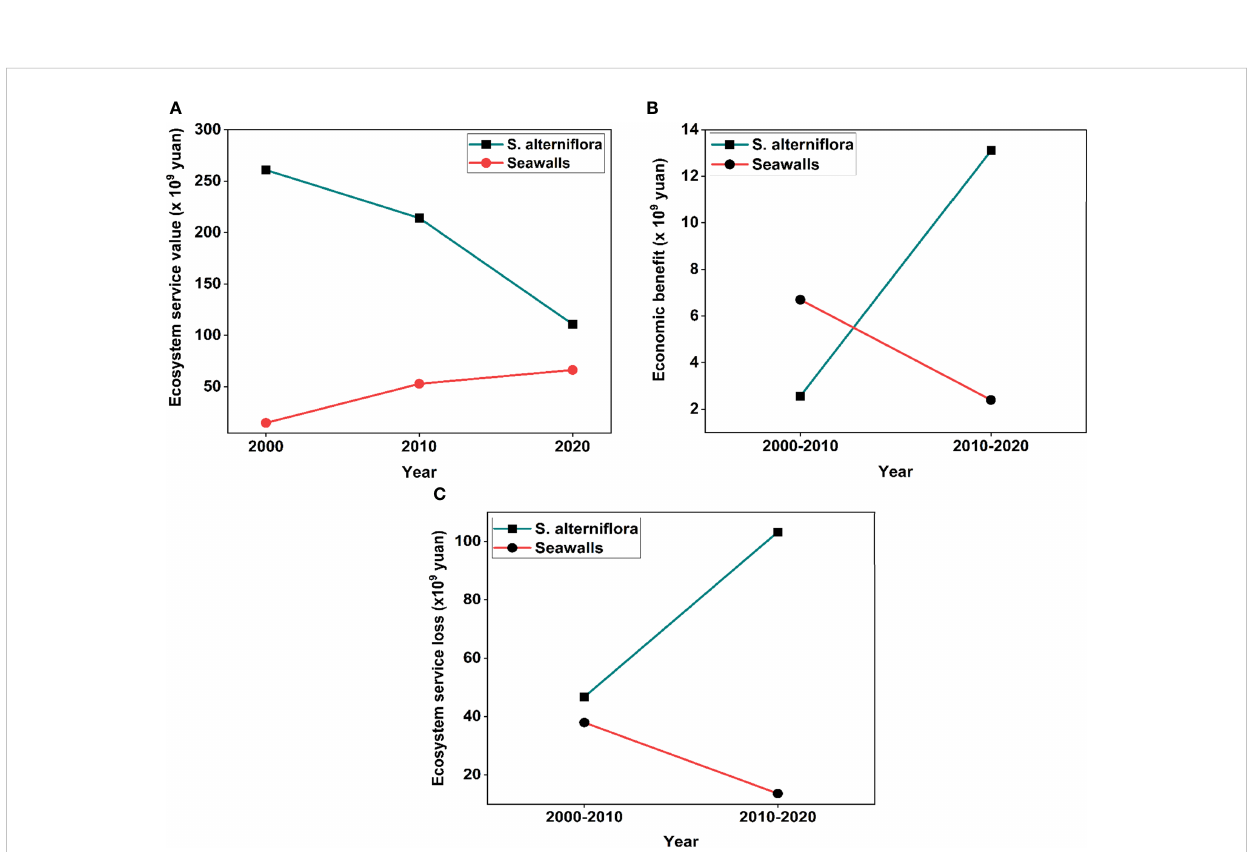
FIGURE 3 (A) the total ecosystem services values of reclamation by S. alterni fl ora and seawall expansion from 2000 to 2020 (B) the economic bene fi t of reclamation by S. alterni fl ora and seawall expansion between 2000 to 2020 (C) the total ecosystem services loss of reclamation by S. alterni fl ora and seawall expansion between 2000 to